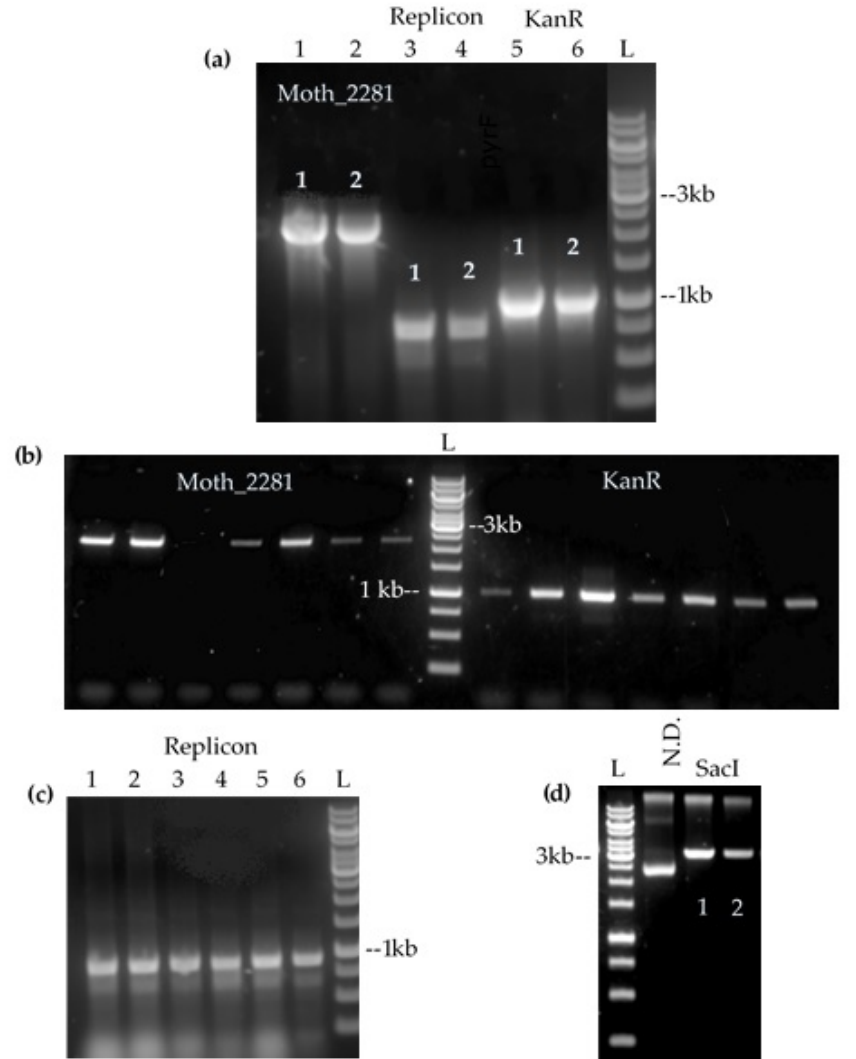
Figure 1. ( a ) Colony PCR of two M. thermoacetica transformants after transformation. Primers amplifying the Gram-positive replicon (Replicon) and the kanR gene (KanR) were used to check presence of the pMTLK-Tp plasmid. As a control, primers amplifying the gene Moth_2281 on the chromosome were used. Two individual transformants are shown. ( b ) Colony PCR of M. thermoacetica transformants after 5 generations in selective cultures with primers amplifying Moth_2281 and kanR . ( c ) Colony PCR of the Gram-positive replicon of plasmid pMTLK-Tp in E. coli after plasmid extraction from M. thermoacetica transformants and retransformation into E. coli . Six isolated colonies are analysed here. ( d ). Plasmid from colonies 1 and 2 from ( c ) was extracted and digested for further analysis with the unique cutter SacI. N.D.: non-digested control. L: molecular